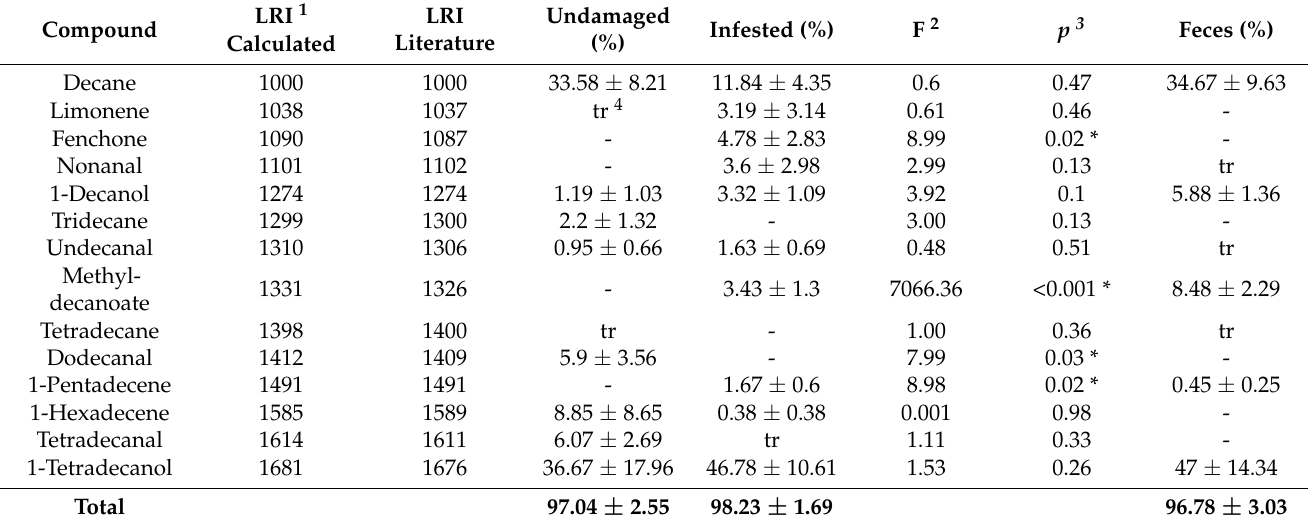
Table 3. Volatile Organic Compunds (VOCs) identified by GC-MS analyses from different host substrates: undamaged and R. dominica -infested wheat, and R. dominica larval feces. Relative percentages of peak areas are mean ± standard error of three replicates. Asterisks (*) indicate significant differences between relative percentages of the same compound between undamaged and infested wheat (One-way ANOVA; p <